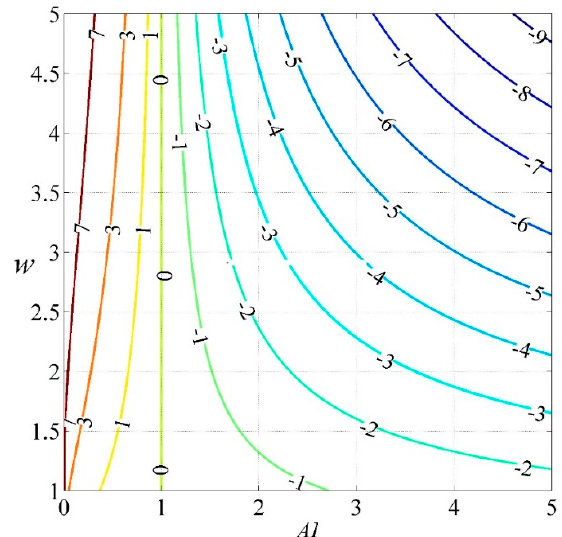
Figure 8. Isoline among WER, parameter w and AI under different climatic conditions.